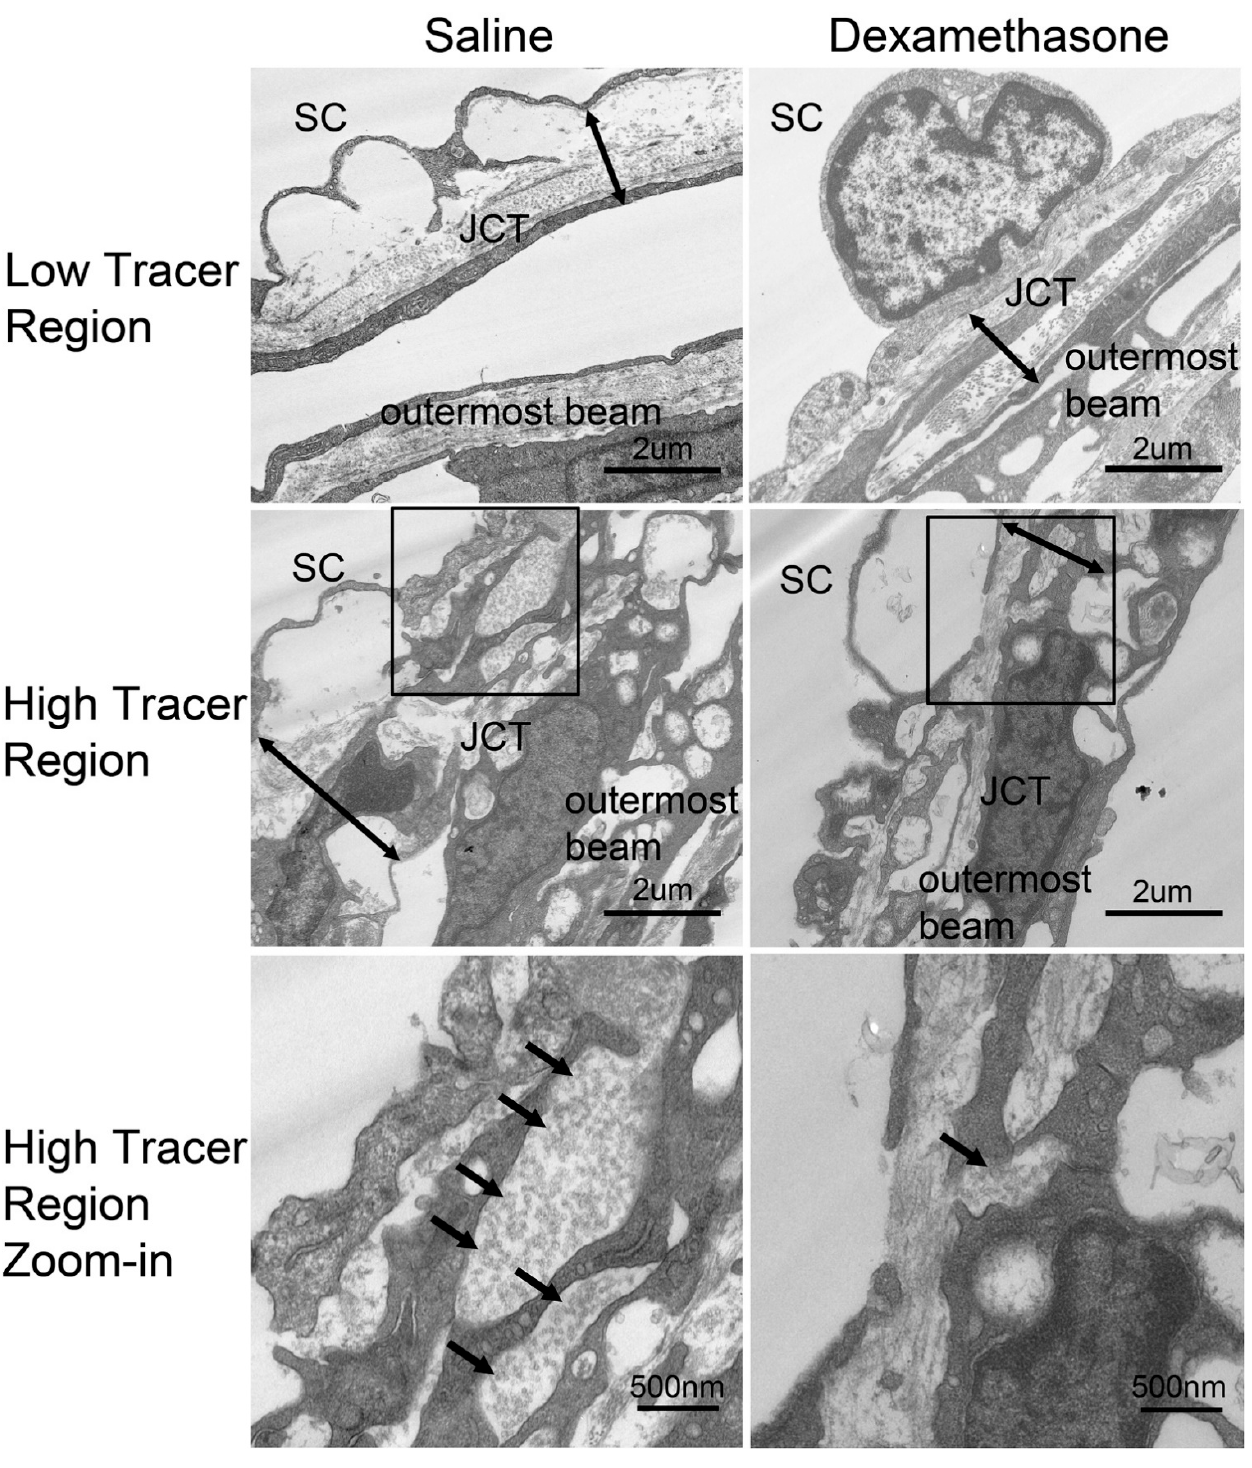
Figure 5. JCT in Low- and High-Tracer Regions. Representative electron microscopy images of the juxtacanalicular tissue (JCT) from low-tracer and high-tracer regions of saline control ( left column) and dexamethasone (DEX)-treated ( right column) eyes. The bottom row presents a larger view of the squared region in the middle row. There are more empty spaces with fluorescent tracers (black arrows) in the JCT in the high-tracer regions of control eyes. Double arrows show the JCT thickness.